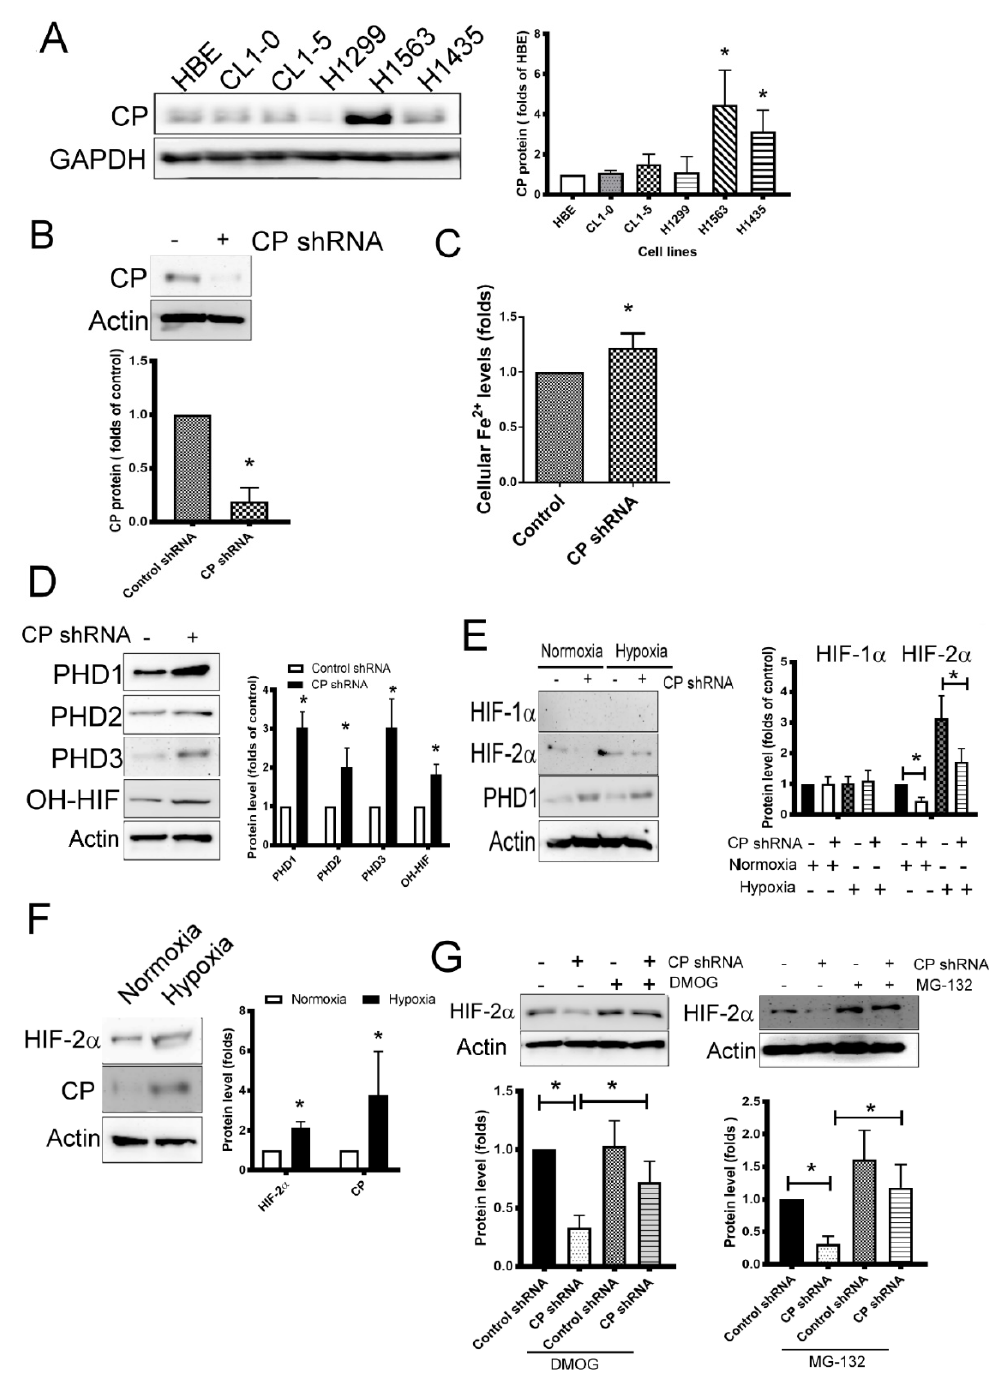
Figure 2. CP increases the stabilization of hypoxia-inducible factor (HIF)-2 α . ( A ) The expression of CP in human bronchial epithelia (HBE) and various lung cancer cell lines. ( B ) The level of CP protein in CP-knockdown H1563 cells. ( C ) The cytosolic Fe 2 + levels of CP-knockdown H1563 cells. ( D ) The level of prolyl hydroxylase domains (PHDs) and hydroxylated HIF (OH-HIF). ( E ) The levels of HIFs and PHD1 in CP-knockdown H1563 cells under either a normoxic or hypoxic condition. ( F ) Hypoxia increased CP and HIF-2 α protein expression in H1563 cells. ( G ) CP increased HIF-2 α level in a PHD-dependent and proteasome-dependent manners. H1563 cells were transfected with control or CP shRNA plasmid, and stable clones were established by puromycin selection. H1563 cells were treated with DMOG (75 µ M) and MG-132 (10 µ M) for 24 h. The levels of specific protein were detected by Immunoblot. Result is representative of at least three independent experiments. * p < 0.05.